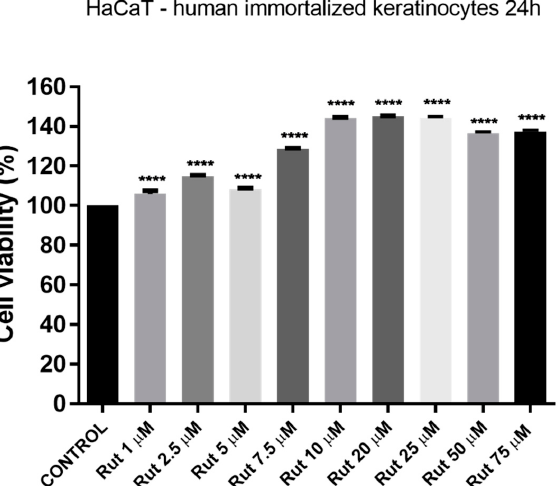
Figure 8. Evaluation of the in vitro effect of rutin (Rut; 1, 2.5, 5, 7.5, 10, 20, 50, and 75 µ M) on human immortalized keratinocytes (HaCaT) viability after a 24 h treatment by applying the alamarBlue assay. The data are presented as cell viability percentage (%) normalized to control cells and expressed as mean values ± SD of three independent experiments performed in triplicate. Statistical differences between the control and the treated cells were calculated by one-way ANOVA analysis, followed by Tukey’s post-test ( p < 0.0001 indicated by ****).